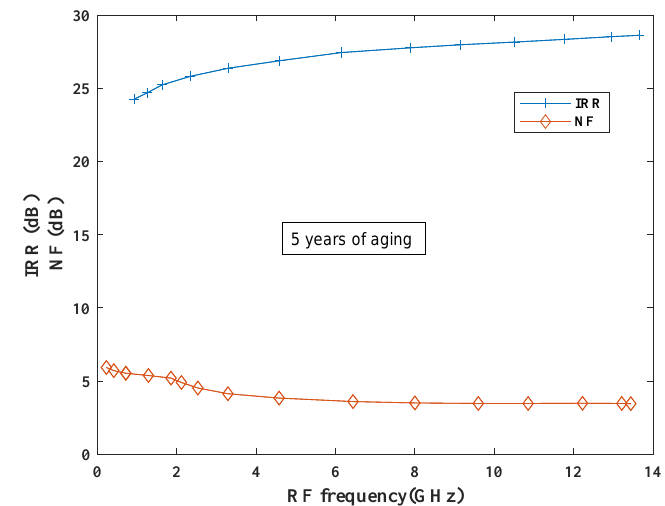
Figure 20. IRR and NF degradation performance.